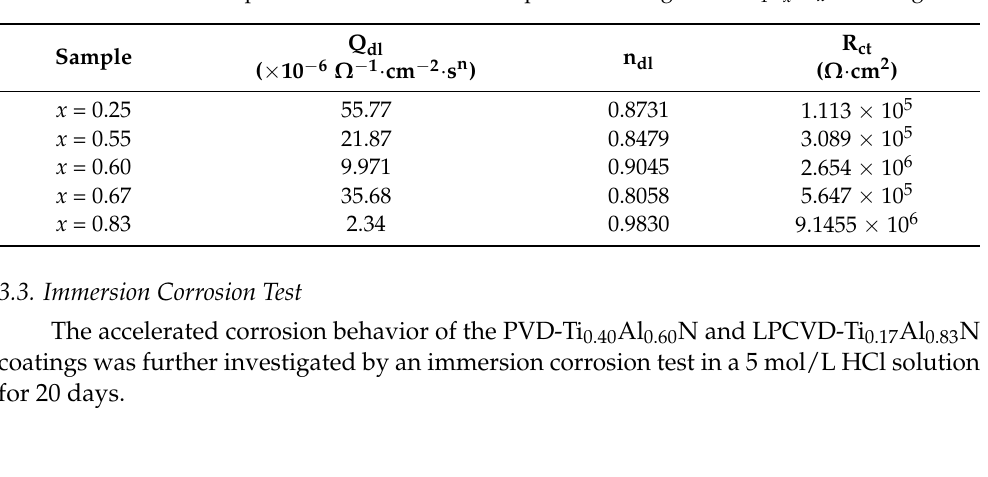
Figure 5. Electronic equivalent circuit used in the fitting procedure of the EIS data. Table 1. Electrochemical parameters derived from impedance fitting of the Ti 1 − x Al x N